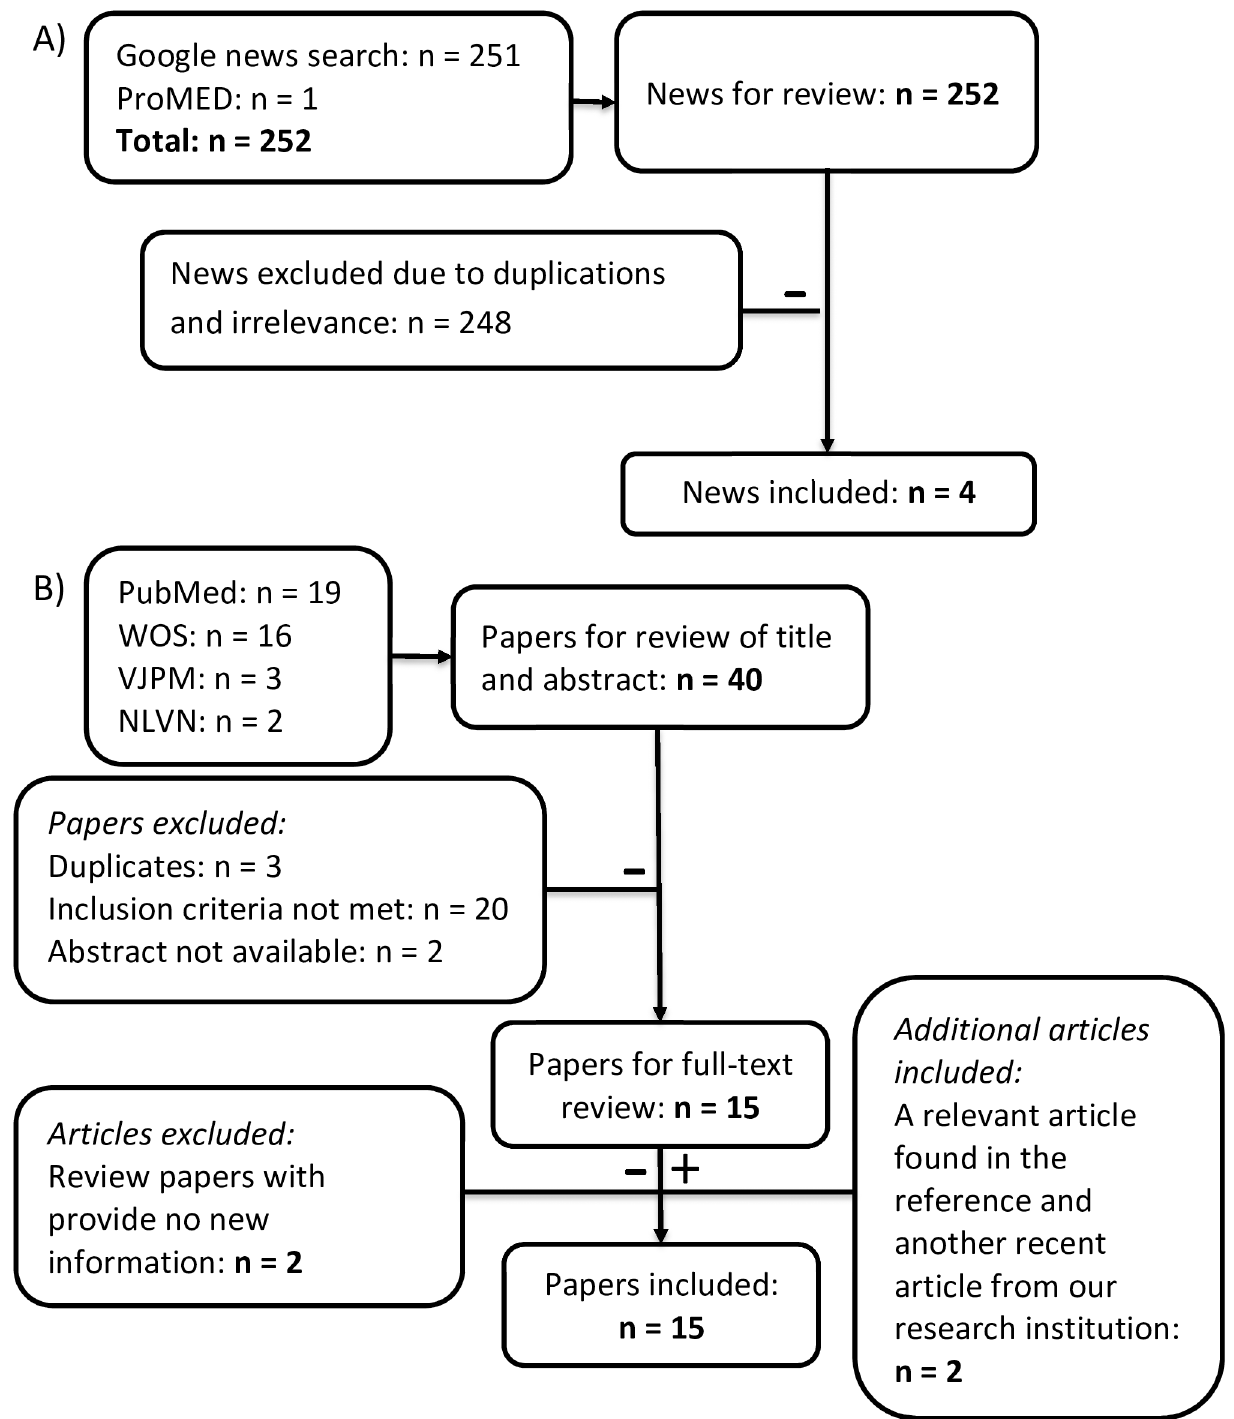
Fig 2. Flowchart describing the systematic review procedure searching for information of CHIKV activity in Vietnam. A) Searching procedure in Google news and ProMED. B) Searching procedure in international journals and national Vietnamese journals . Abbreviations: WOS = Web of Science, VJPM = Vietnam Journal of Preventive Medicine, and NLVN = National Library of Vietnam.